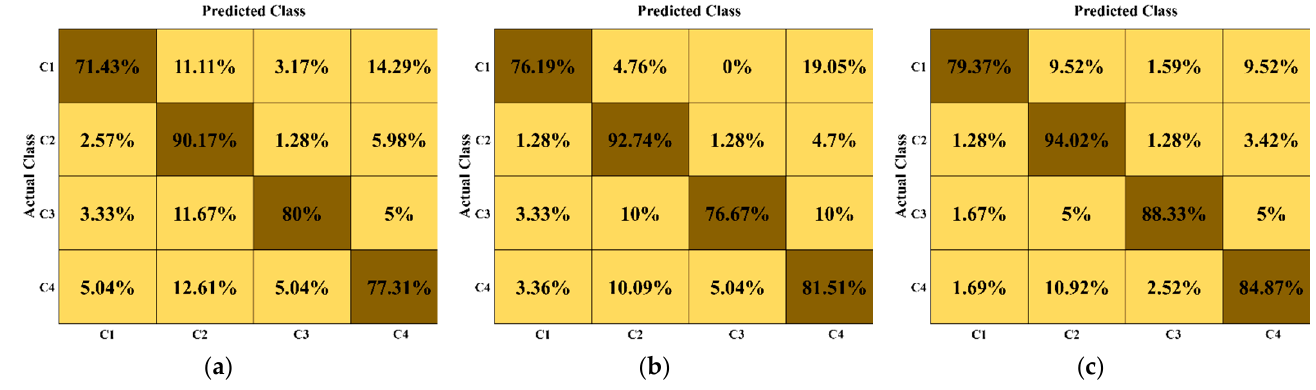
Figure 4. A comparison between the performance of the proposed IMFC-Net with that of the base models in terms of confusion matrices (unit: %): ( a ) the confusion matrix of the base model [27], ( b ) the confusion matrix of the base model [23], and ( c ) the confusion matrix of the proposed model. (C1: Cofield manufacturer, C2: Depuy manufacturer, C3: Tornier manufacturer, and C4: Zimmer manufacturer).